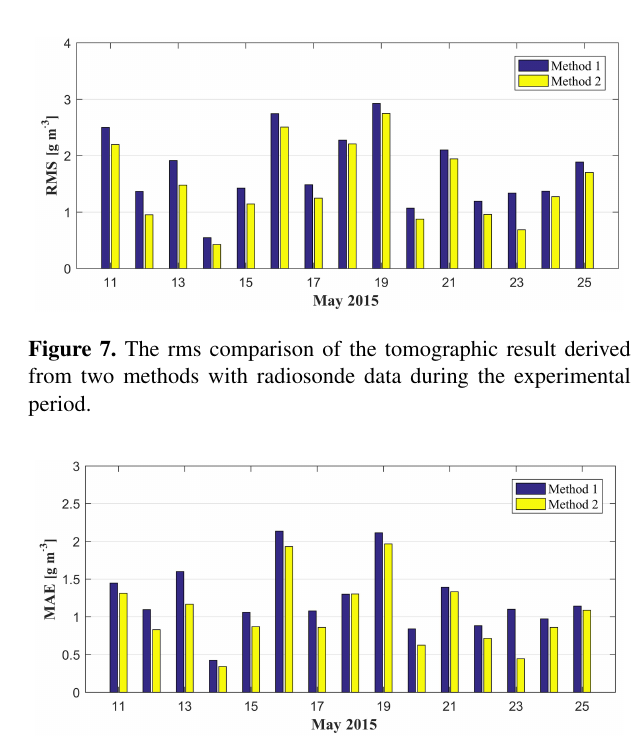
Figure 8. The MAE comparison of the tomographic result derived from two methods with radiosonde data during the experimental